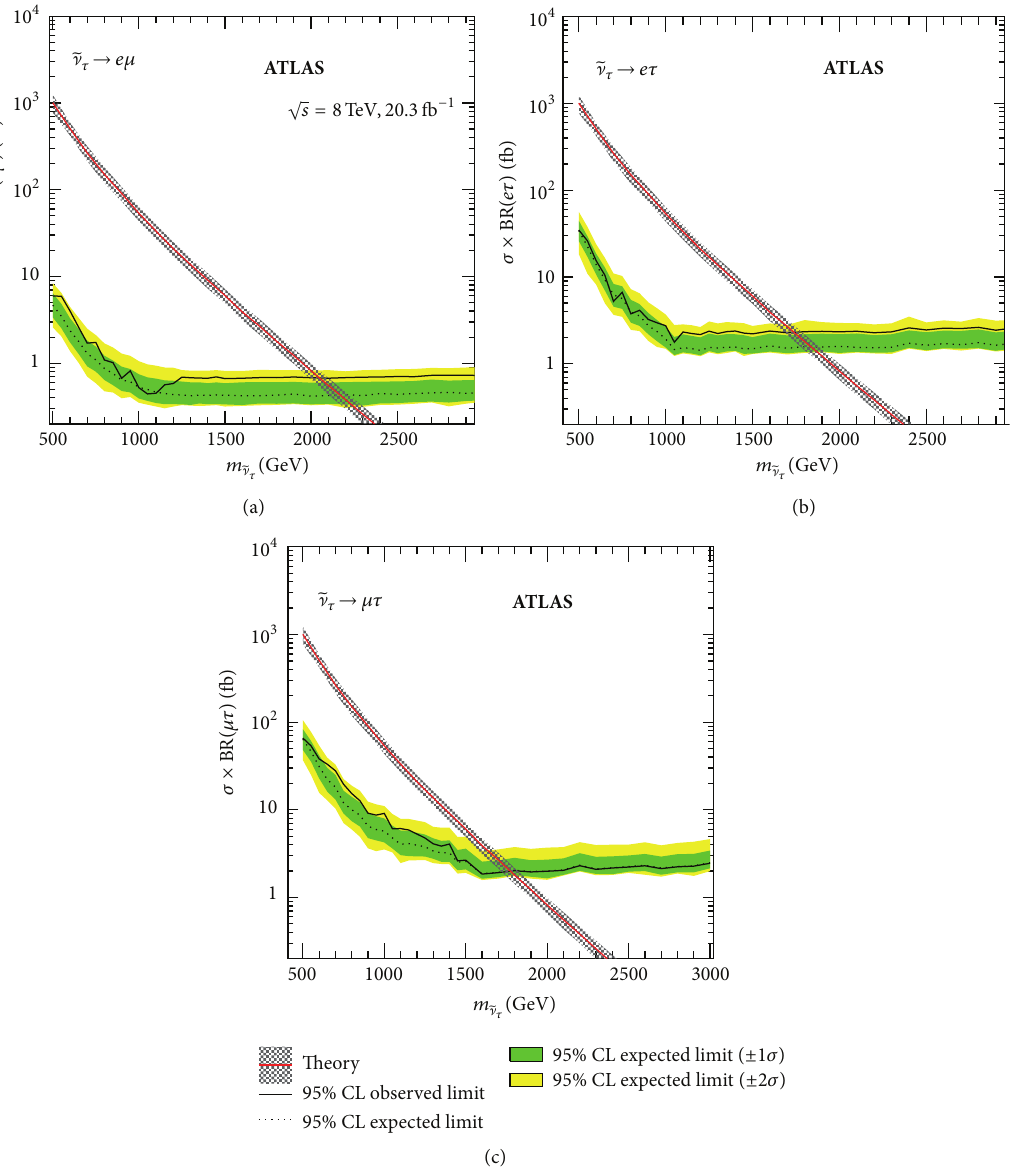
Figure 10: The 95% CL limits on cross section times branching ratio as a function of ̃ ] 𝜏 mass for 𝑒𝜇 (a), 𝑒𝜏 (b), and 𝜇𝜏 (c) (from [43]). Theory curves correspond to 𝜆 󸀠 311 = 0 . 11 and 𝜆 𝑖 3 𝑘 = 0 . 07 for ̃ ] 𝜏